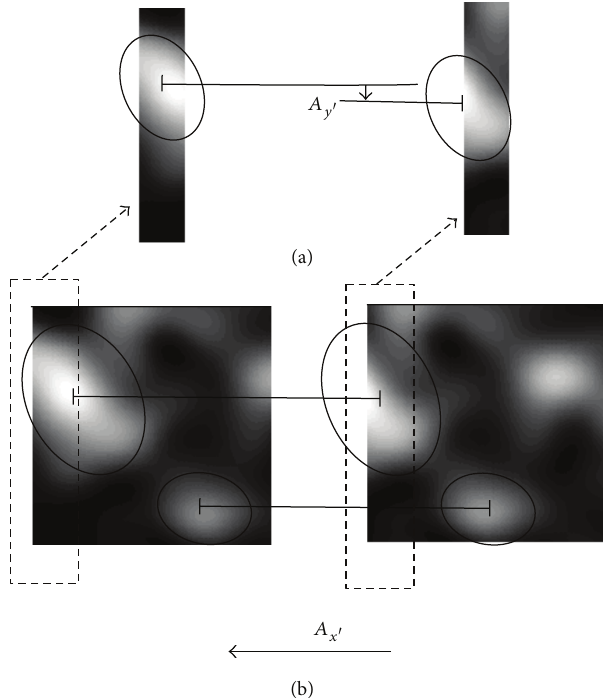
Figure 3: Displacement of speckle pattern detected (a) in a selected narrow rectangular area of a detector, (b) in the whole area of the detector. Black ovals delimit shape of individual speckles. Speckle patternisonlyshiftedby 𝐴 𝑥 󸀠 ,whereas 𝐴 𝑦 󸀠 = 0 .However,thespeckle pattern displacement 𝐴 𝑦 󸀠 evaluated in the case (a) is 𝐴 𝑦 󸀠 ̸= 0